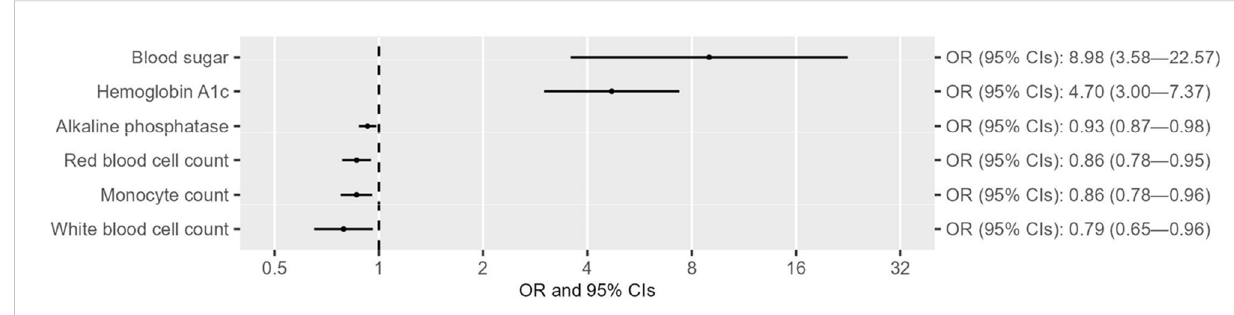
FIGURE 2 Forest plots showing the causal effect of traits on T2D with suggestive levels of evidence ( P < 0.05) in the East Asian